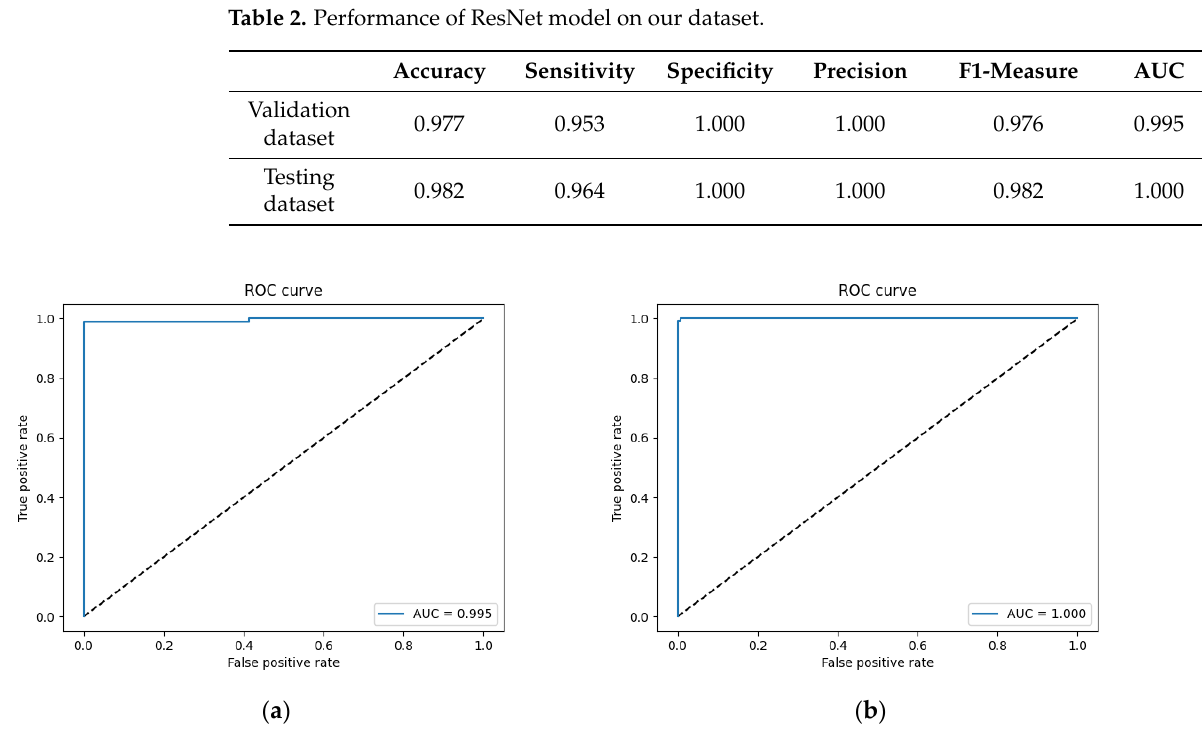
Figure 10. ROC curve of ( a ) validation set and ( b ) testing set. Table 1. Confusion matrix of the model.